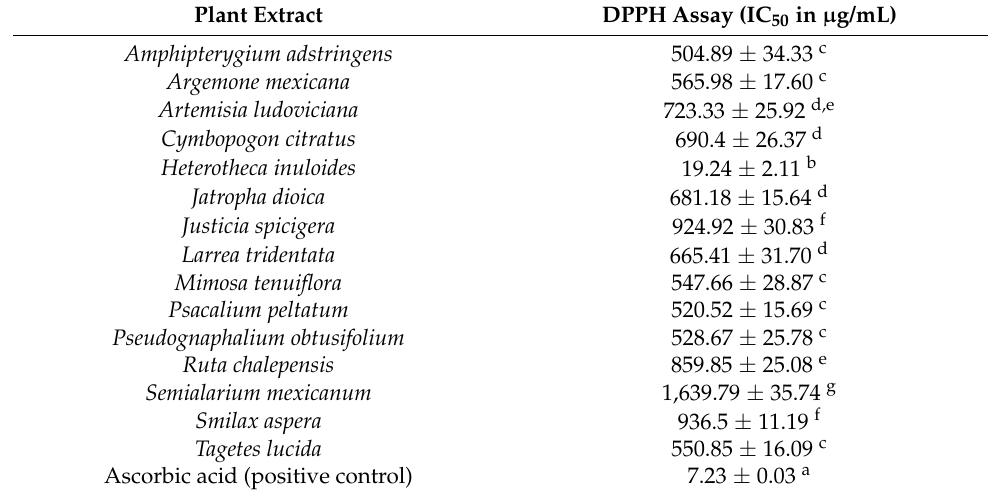
Table 3. Antioxidant activity of methanol plant extracts by the DPPH radical scavenging method. Plant